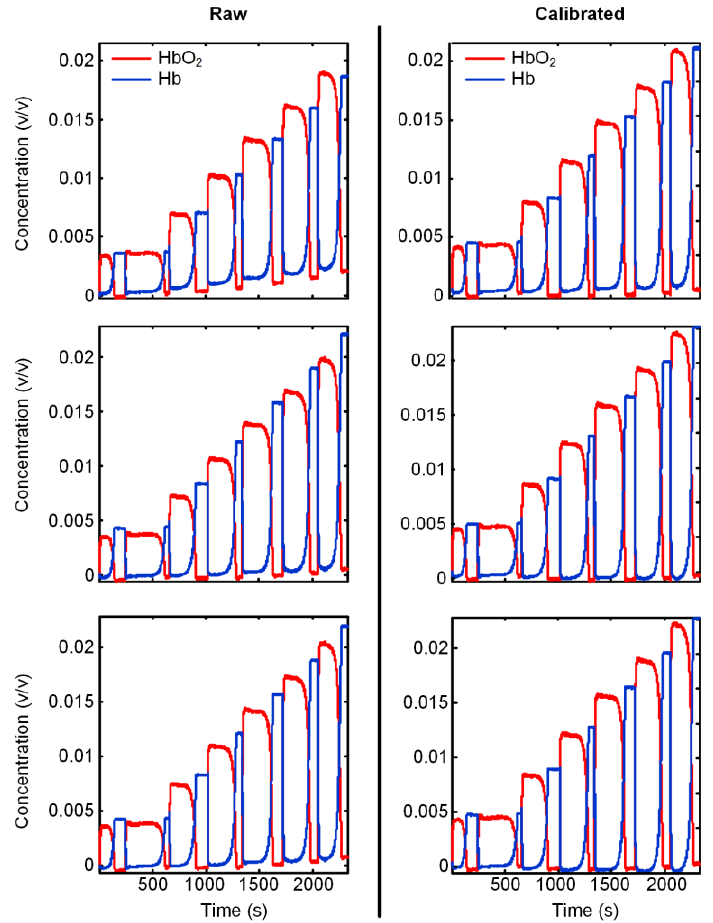
Figure 3. Hemodynamic parameters measured without calibration and with calibration for a typical subject as an example, using fourth-order polynomial detrending.